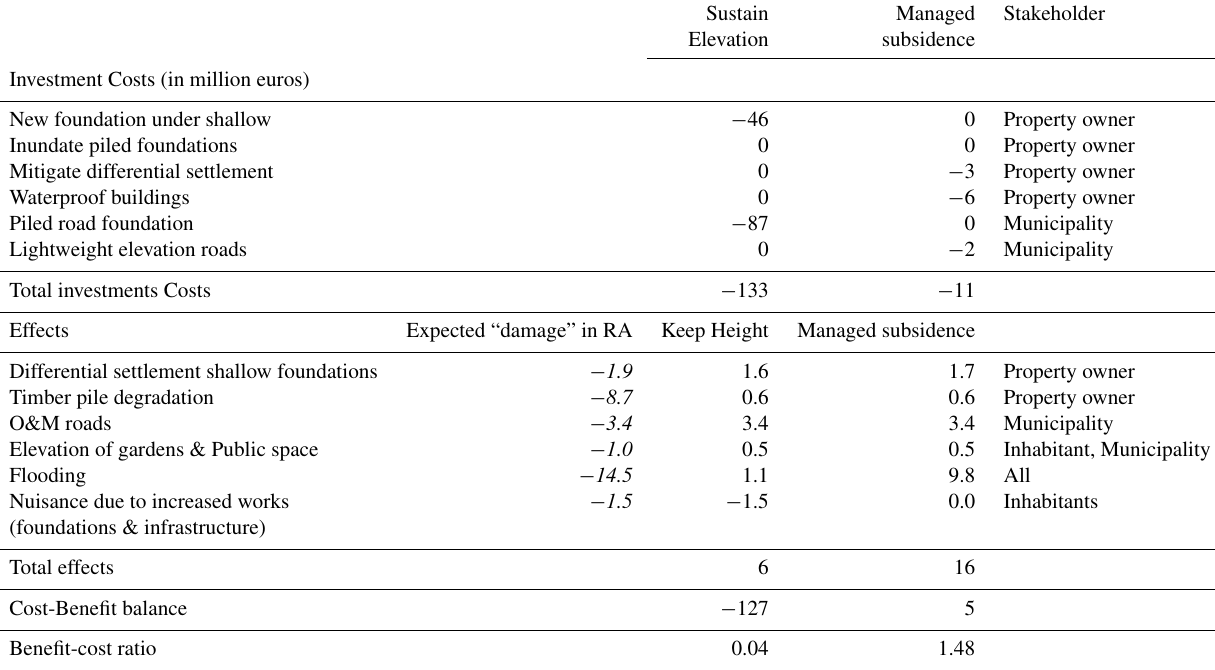
Table 2. Overview of investment costs and benefits (in EUR10 6 ) of alternatives Sustain Elevation and Managed Subsidence – the latter expressed as reduced damage/lower costs in relation to the reference alternative (RA). Expected damage in RA is expressed in italic. Sustain